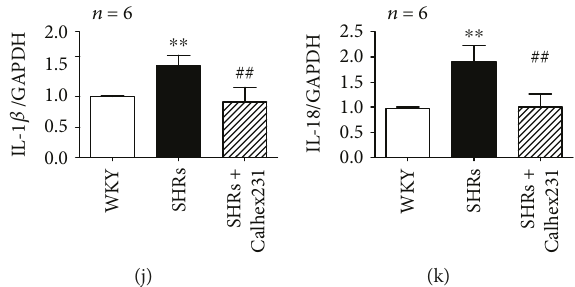
Figure 1: Calhex 231 attenuated NLRP3 in fl ammasome activation in the aortas of SHRs. (a) Immunohistochemistry was used to detect CaSR expression in the aortas of rats. Quanti fi cation of the relative CaSR protein levels in these arteries demonstrated that CaSR was increased in SHRs and decreased by antagonist of CaSR, bar =50 μ m, n = 5 . (b) Western blot analysis of CaSR, NLRP3, ASC, and caspase 1. (c – g) Bar graphs showed the quantitative analyses of the proteins from B. (h) Representative western blot images of pro-IL-1 β , IL-1 β , and IL-18 in the aortas from experimental rats. (i – k) Quantitative analyses of proteins from in H. ∗∗ P < 0 01 and ∗∗∗ P < 0 001 vs. WKY; # P < 0 05 , ## P < 0 01 , and ## P < 0 001 vs. SHRs.